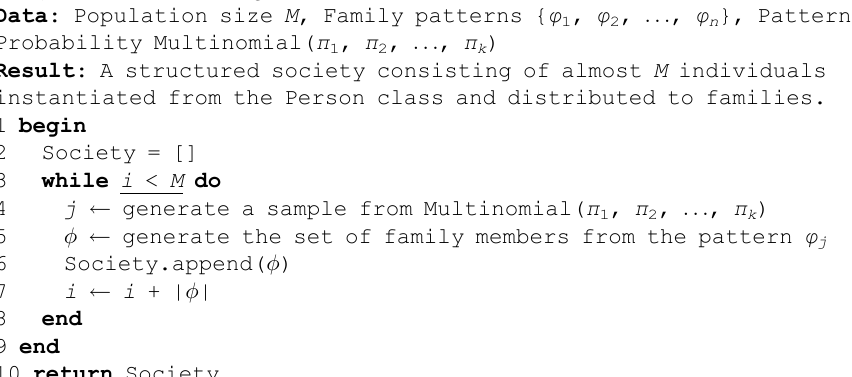
Algorithm 1 : Generating the